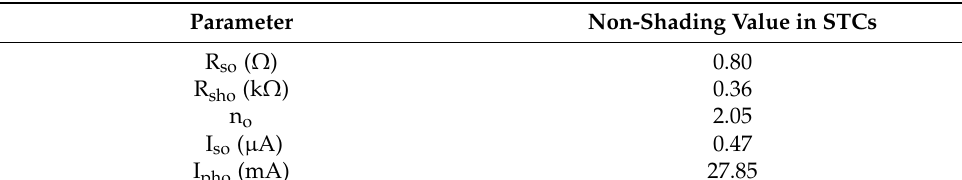
Table 1. The equivalent circuit parameters of the solar cell (0.8 cm 2 active area) in STCs. They were used as the non-shading reference in the model for the calculation of the shading influence. The data was extracted from an I-V curve obtained from the average of three measurements. Parameter Non-Shading Value in STCs